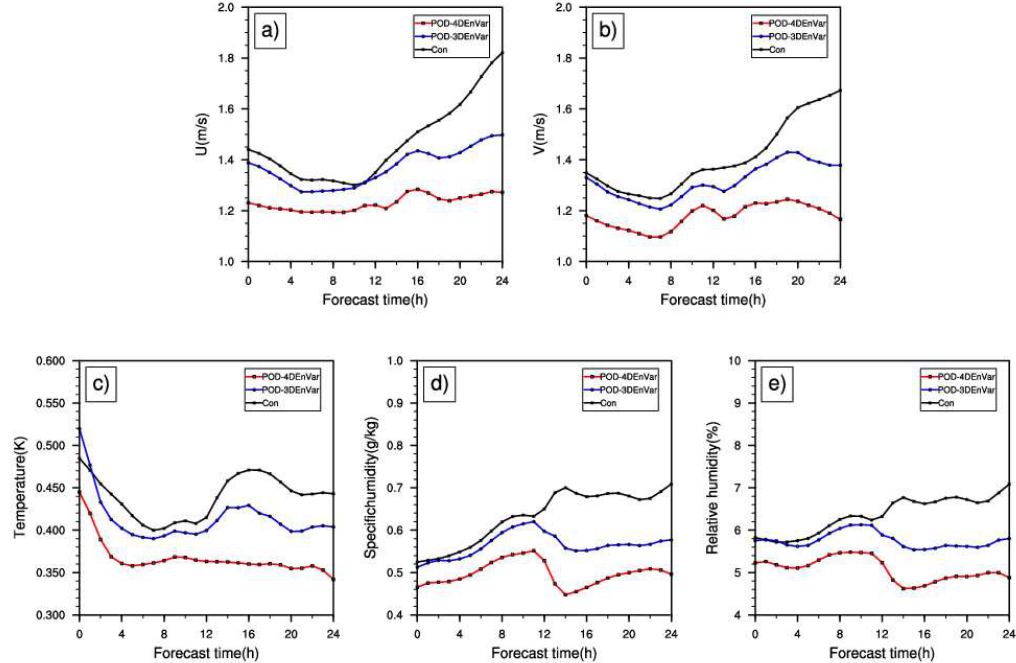
Figure 8. The RMSEs of forecast field of cycling assimilation for Con, POD-3DEnVar, and POD-4DEnVar initialized at 00:00 UTC on 29 June 2009 ( a ) u winds (unit: m s − 1 ) ( b ) v winds (unit: m s − 1 ) ( c ) temperature (unit: K) ( d ) water vapor mixing ratio (unit: g/kg) ( e ) relative humidity (unit: %). The results are calculated for 700 hPa horizontal domain.